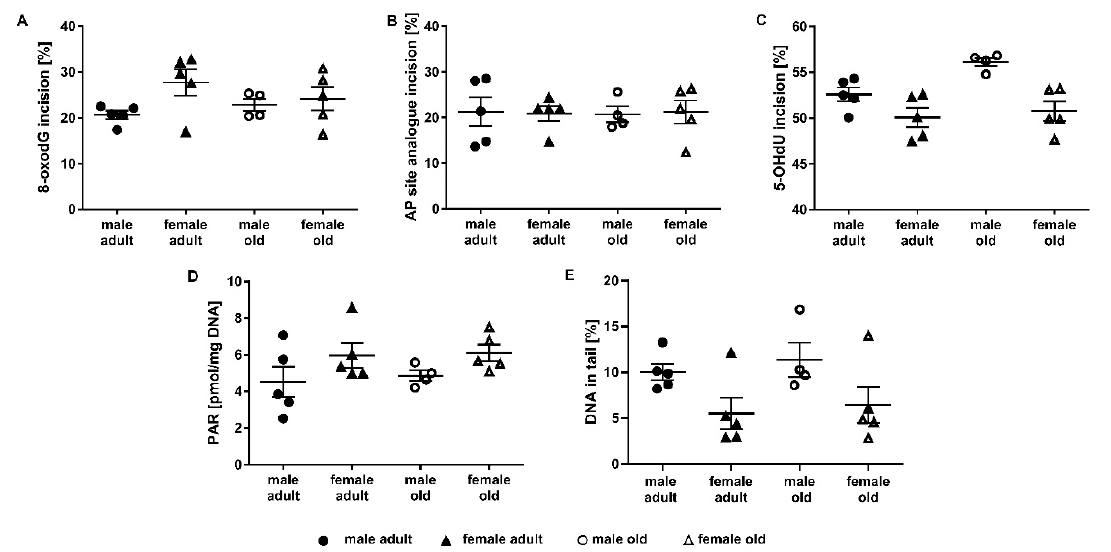
Figure A1. Impact of age and sex on incision activity, PARylation, and DNA damage levels. Shown is BER incision activity (individual single measurement scores per animal and group mean ± SEM) of murine liver of adult (24 weeks, n = 10) and old (109-114 weeks, n = 9) animals of both sexes (female: n = 10, male: n = 9) towards ( A ) the 8-oxodG, ( B ) the AP site analogue, and ( C ) the 5-OHdU containing oligonucleotide. Additionally, shown are PARylation levels (individual single measurement scores per animal and group mean ± SEM) ( D ) and DNA damage levels (individual single measurement scores (two technical replicates) and group mean ± SEM) ( E ).